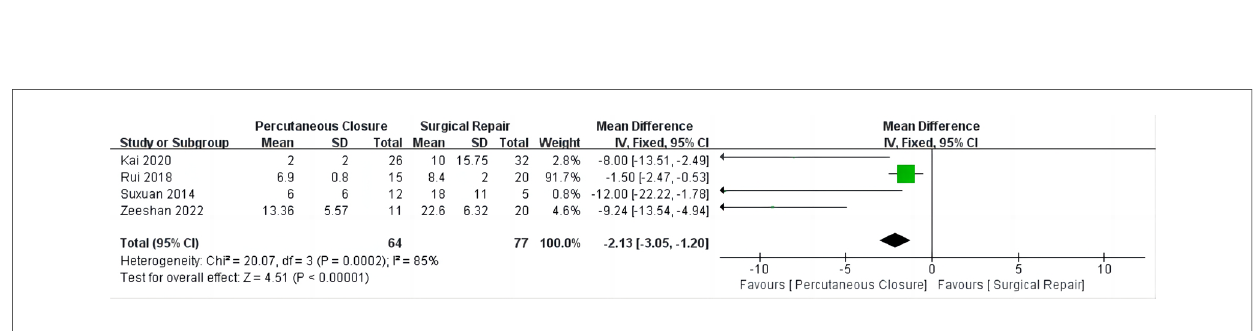
FIGURE 5 Comparing length of postoperative hospital stay between percutaneous closure and surgical